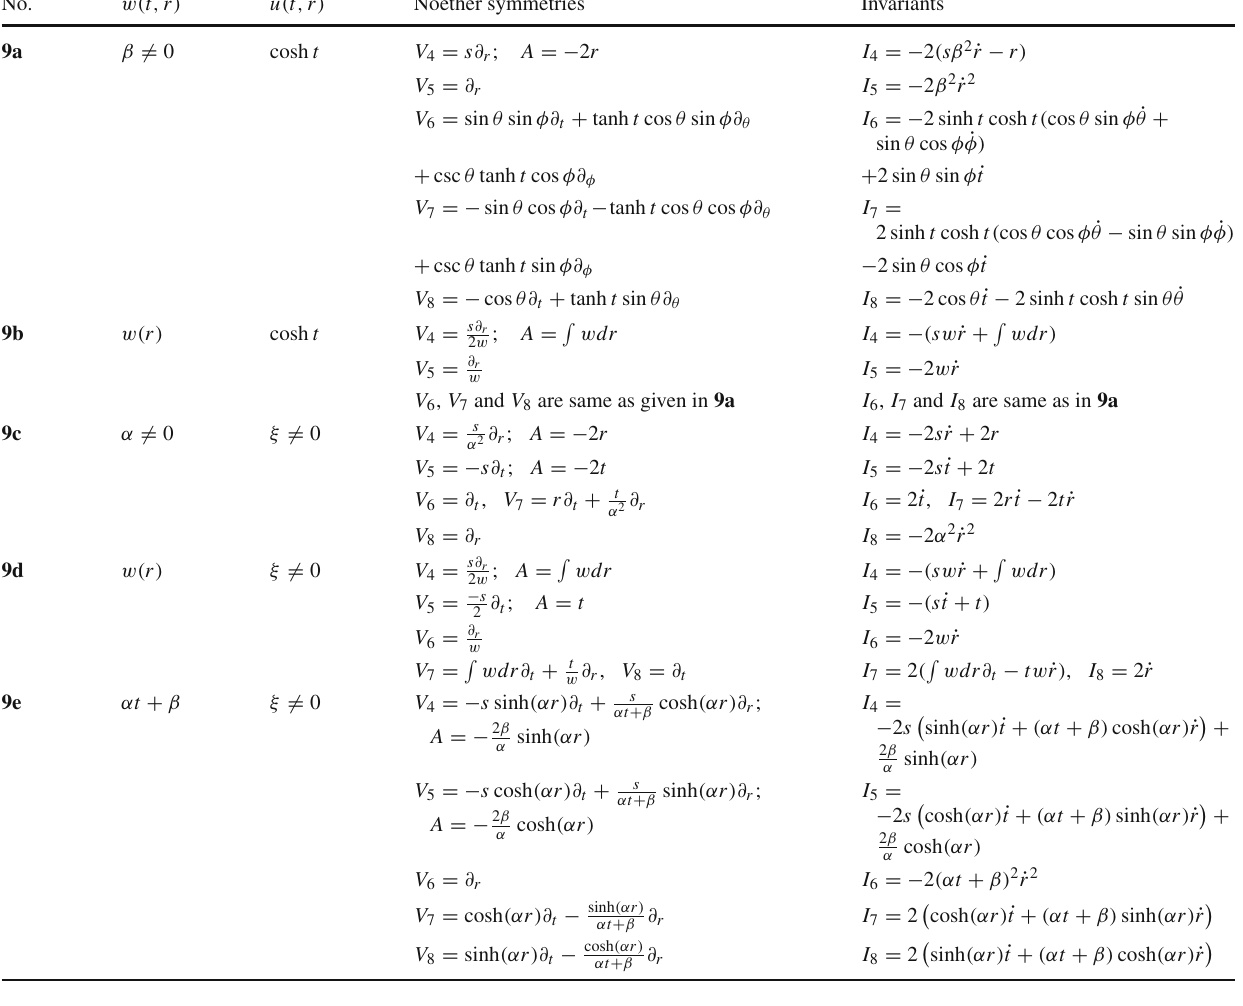
Table 5 Metrics admitting nine Noether